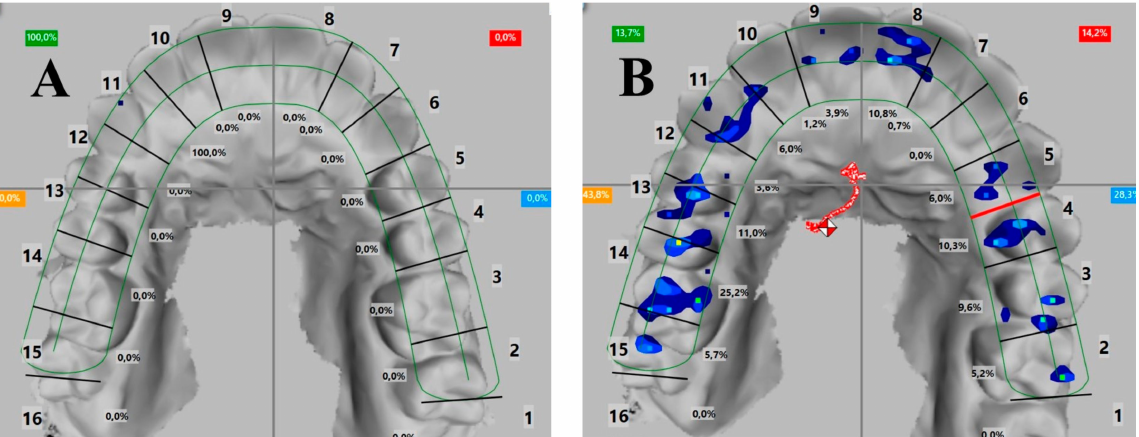
Figure 4. ( A ) First contact (T-Scan system) on the upper right canine. ( B ) Quadrant distribution and lower jaw movement (T-Scan system). The system divides the dentition into four quadrants: left and right frontal and left and right distal. The force distribution is shown on each tooth. The path of the lower jaw movement is also